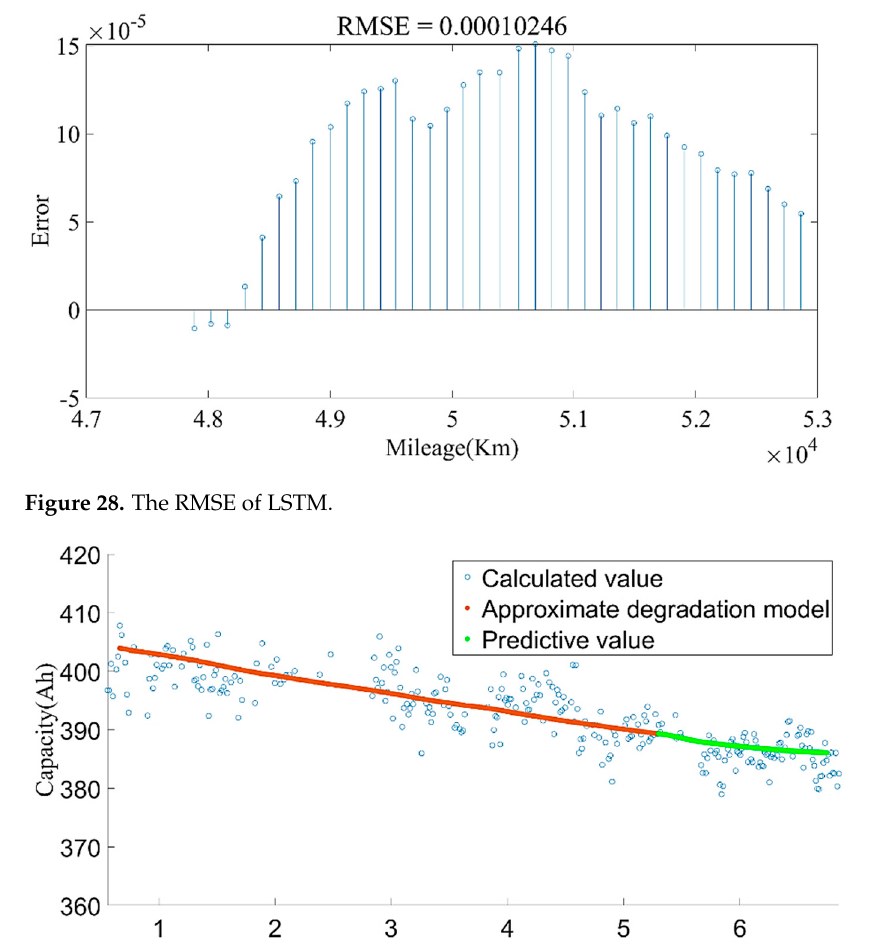
Figure 27. The SOH estimation result based on LSTM.